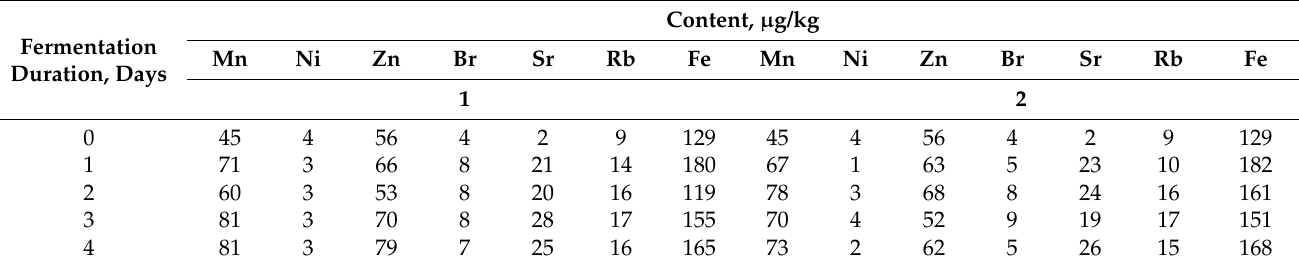
Table 2. The results of quantitative determination of the content of trace elements in samples at different fermentation